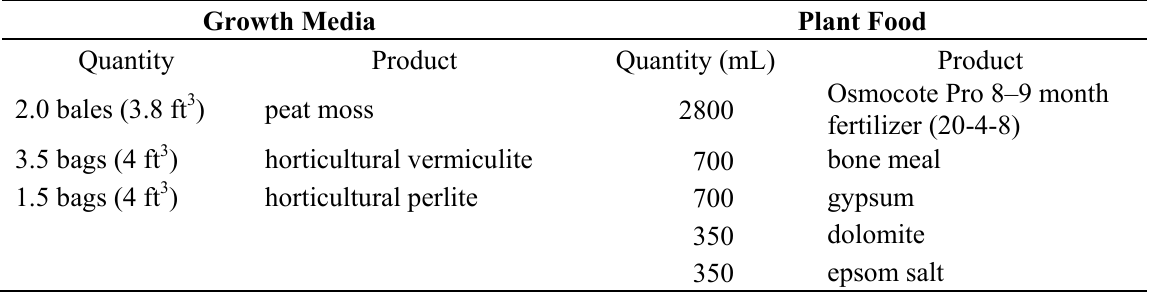
Table 1. Potting mix recipe for greenhouse seedling and germinal screenings †